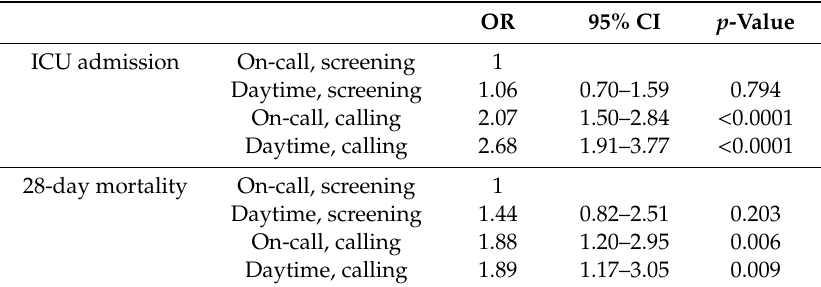
Table 3. Clinical outcomes among patients with surgical